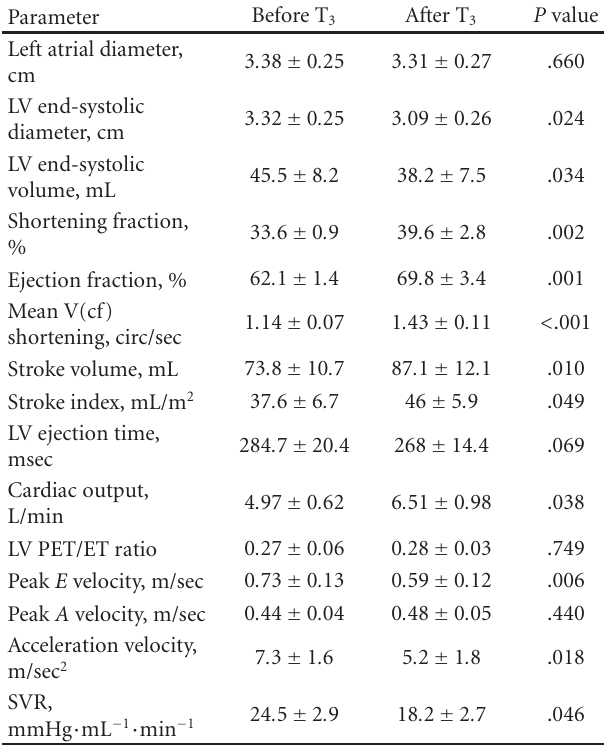
Table 2: Echocardiographic characteristics of the study population before and after T 3 administration.